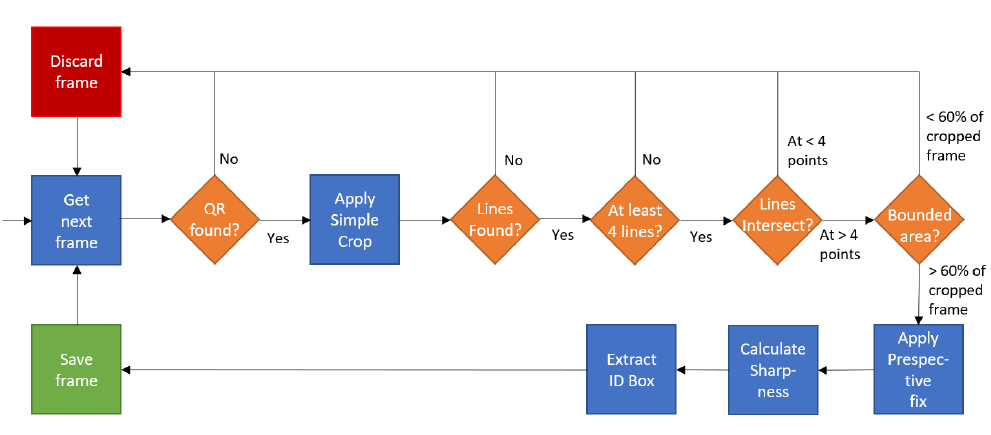
Figure 12. Frame processing